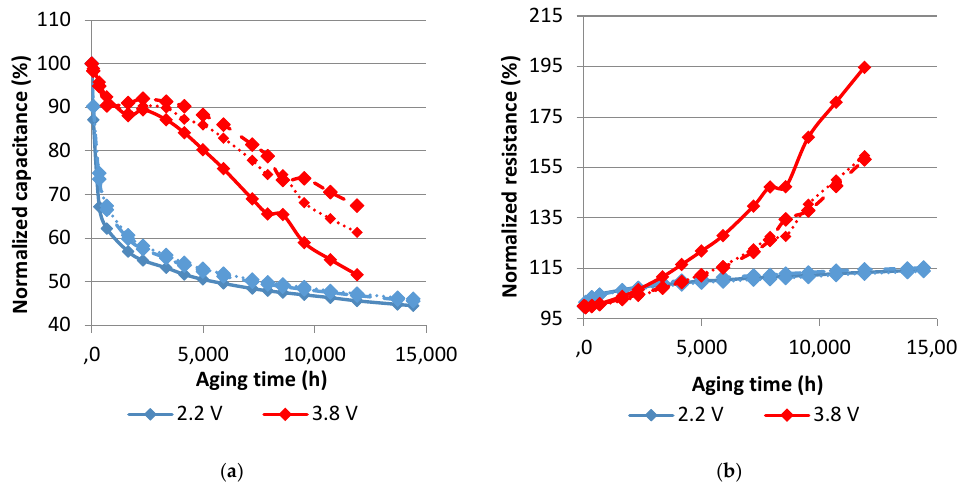
Figure 7. Evolution of the normalized capacitance ( a ) and the normalized resistance ( b ) with aging time at 70°C. Each curve represents one sample.